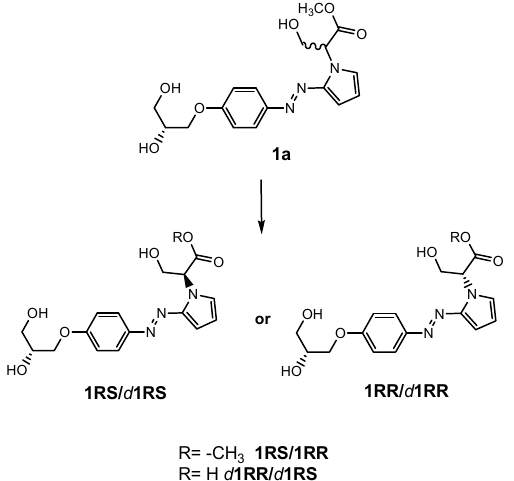
Figure 1. The benzodiazopyrrole derivatives previously described (the diastereomeric mixture and its pure stereomers 1RR and 1RS ) that have shown photo-responsive antiproliferative activity against HCT 116 p53-/- cancer cells [20], and the water soluble deprotected d 1RR and d 1RS herein explored for their photo-responsive properties.